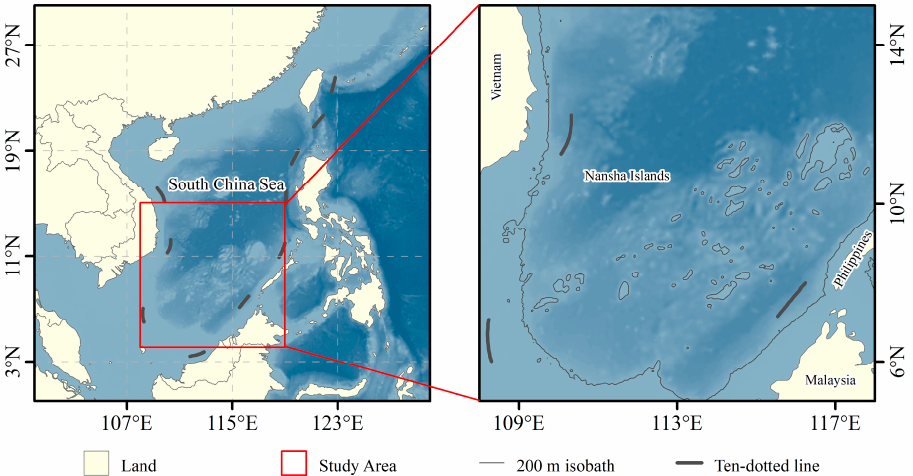
Figure 1. Study Figure 1. Study area.